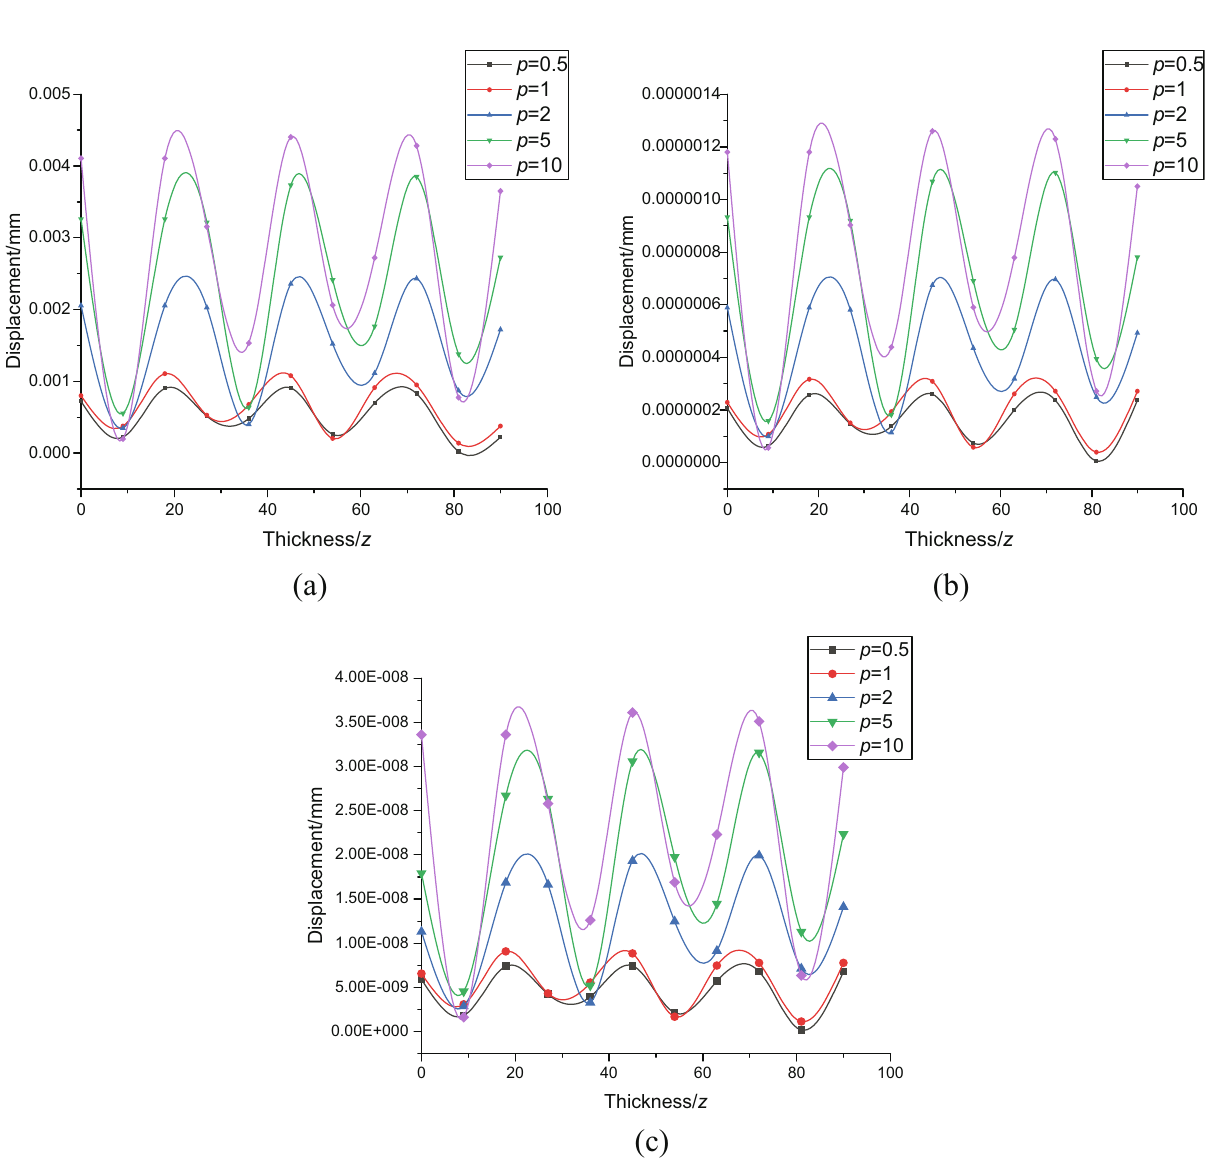
Figure 8: Displacement changes under di ff erent gradient parameters along the thickness with di ff erent x positions. ( a ) x = 0, ( b ) x = 45, and ( c ) x =